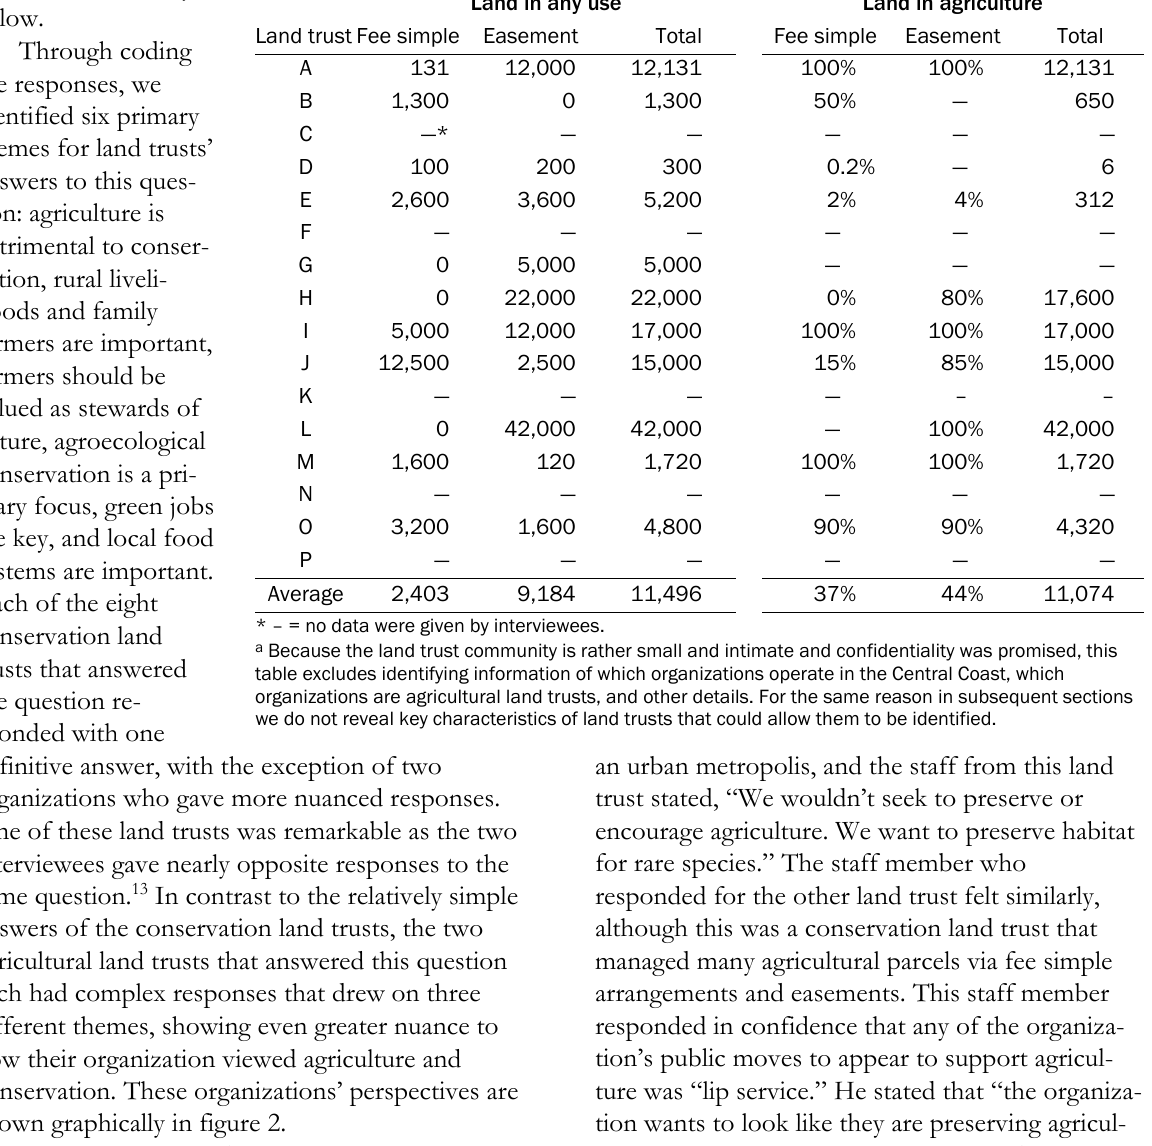
Table 1. Number of Acres Managed by Land Trusts Interviewed a Land in any use Land in